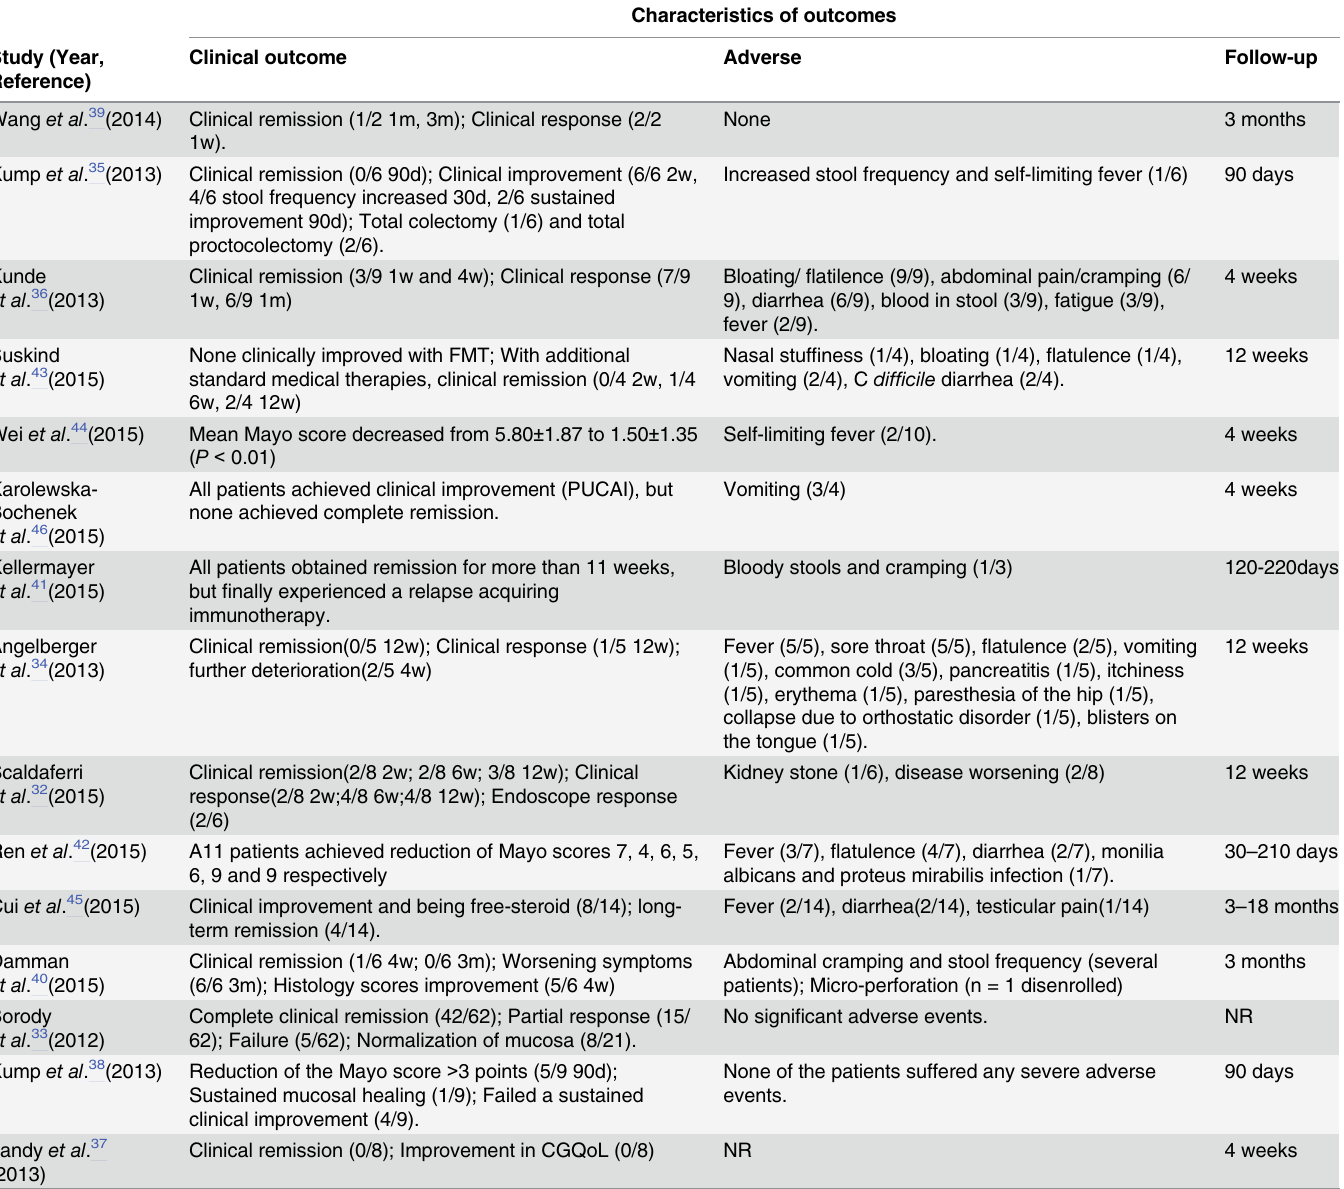
Table 3. Characteristic of cohort studies. (Continued)